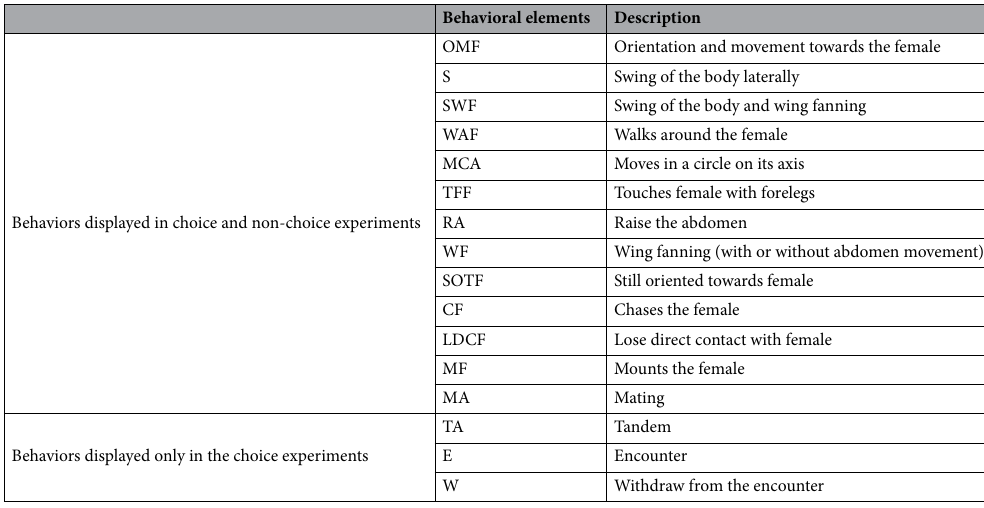
Table 1. Courtship behavioral elements of Anastrepha curvicauda (7–8 days old) males in choice and non- choice